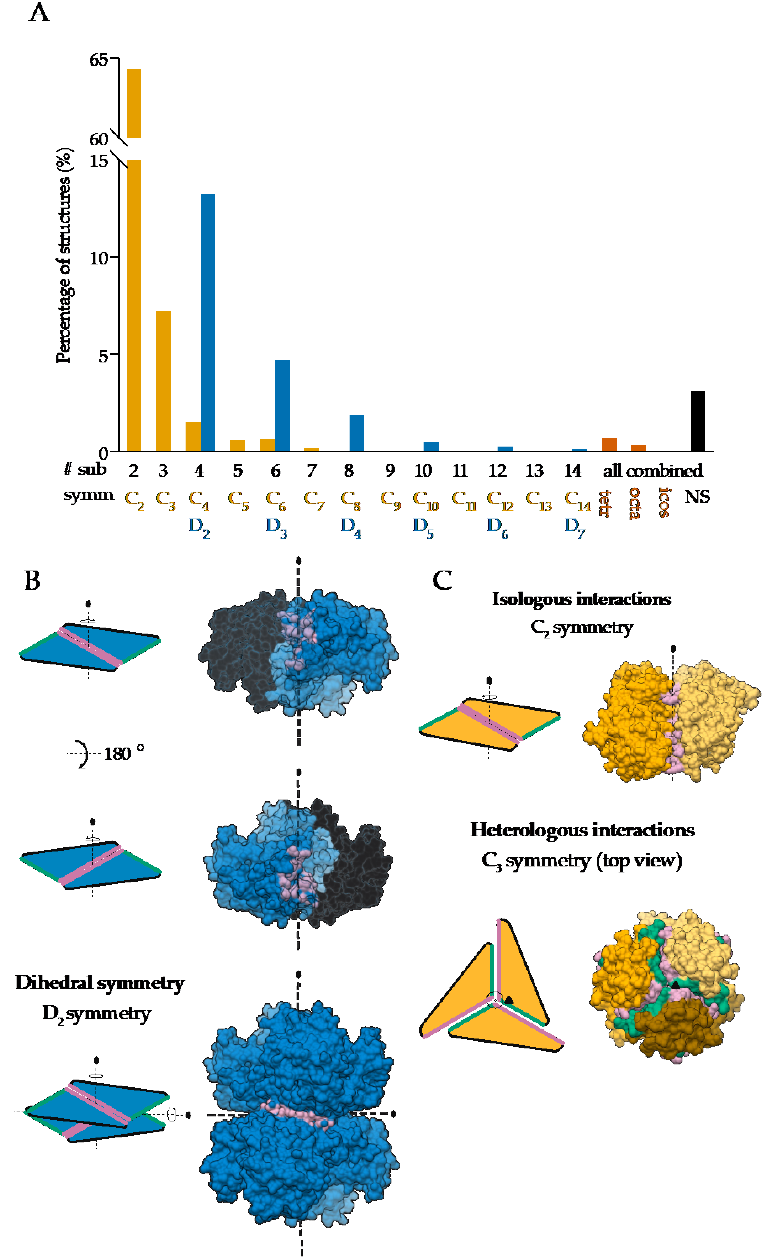
Figure 2. Symmetries observed in the determined structures of homo-oligomeric protein complexes: ( A ) Relative distribution of symmetry types in QSbio with a 90% sequence similarity cutoff. Com- plexes were classified by the number of subunits (# sub) and the symmetry type (symm). Data for tetrahedral (tetr), octahedral (octa), icosahedral (icos) and non-symmetric (NS) complexes are combined for all number of subunits. ( B ) Assembly of a dihedral symmetry from parts of protein complexes with cyclic symmetry, glucose-6-phosphate 1-dehydrogenase (PDB: 6D23) [35]. In the representation of protein surfaces of the C 2 symmetric subcomplexes, one of the subunits is trans- parent to enable visualization of the interaction surface. ( C ) Representation of the isologous and heterologous interactions in complexes with odd and even number of subunits in the case of orange carotenoid-binding protein (PDB: 5UI2) [36] and corrinoid adenosyltransferase (PDB: 2R6T) [37], respectively. Individual subunits are depicted with different shades of yellow. Distinct interaction surfaces are depicted with green and pink, respectively. Two- and three-fold axes are denoted by corresponding